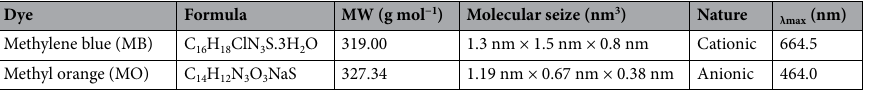
Table 1. Some physico-chemical characteristics of two tested dyes. MW stands for molecular weight.